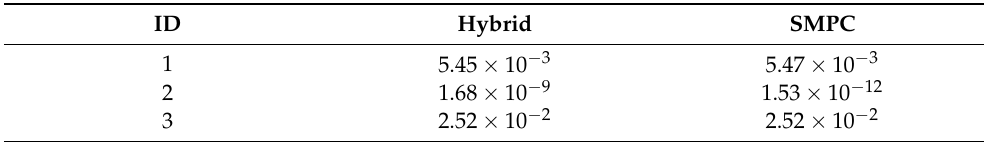
Table 12. Absolute error of calculating the p -value of the t statistic and degree of freedom previously calculated in Table